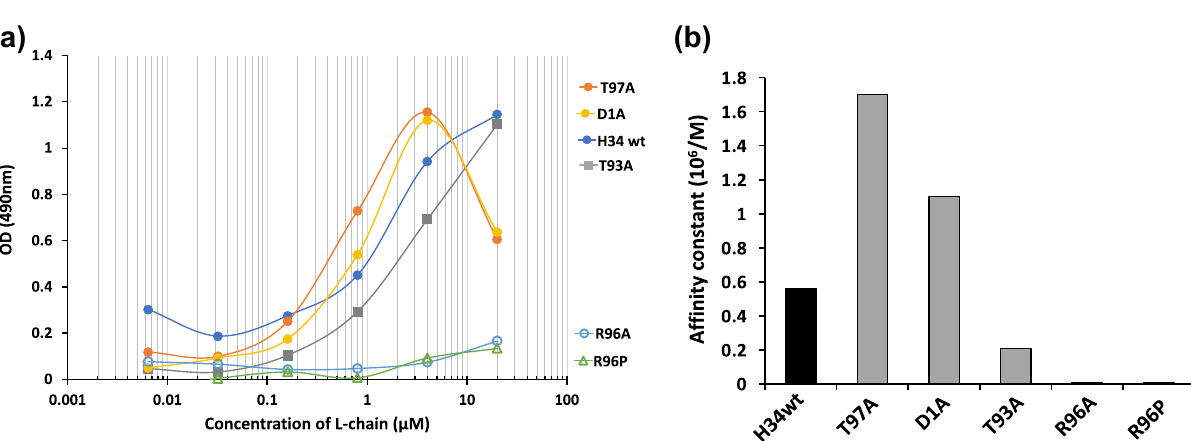
Figure 7. ( a ) ELISA: Coated antigen (rPD1): 2 µg/mL and 50 µL/well. Concentration of H34wt and the mutants: 0.0064–20 µM. Second antibody: POD-goat IGG to human Kappa chain (1/2000 dilution). H34wt shows the typical sigmoid curve of ELISA. Both T97A and D1A mutants shows the sigmoid curve with prozone phenomena. The mutants are divided into two groups. The first group including H34wt, T97A, D1A, and T93A shows binding affinity to rPD-1, while the second group including R96A and R96P hardly binds to rPD-1. This means that Arg96 is strongly involved in the recognition of rPD-1. ( b ) Comparison of affinity constants. The affinity constants, which were calculated from the results of ( a ), are presented for comprehensive comparison. It is clear that the replacement of The93 and Arg96 to Ala (or Pro) decreased the antigen